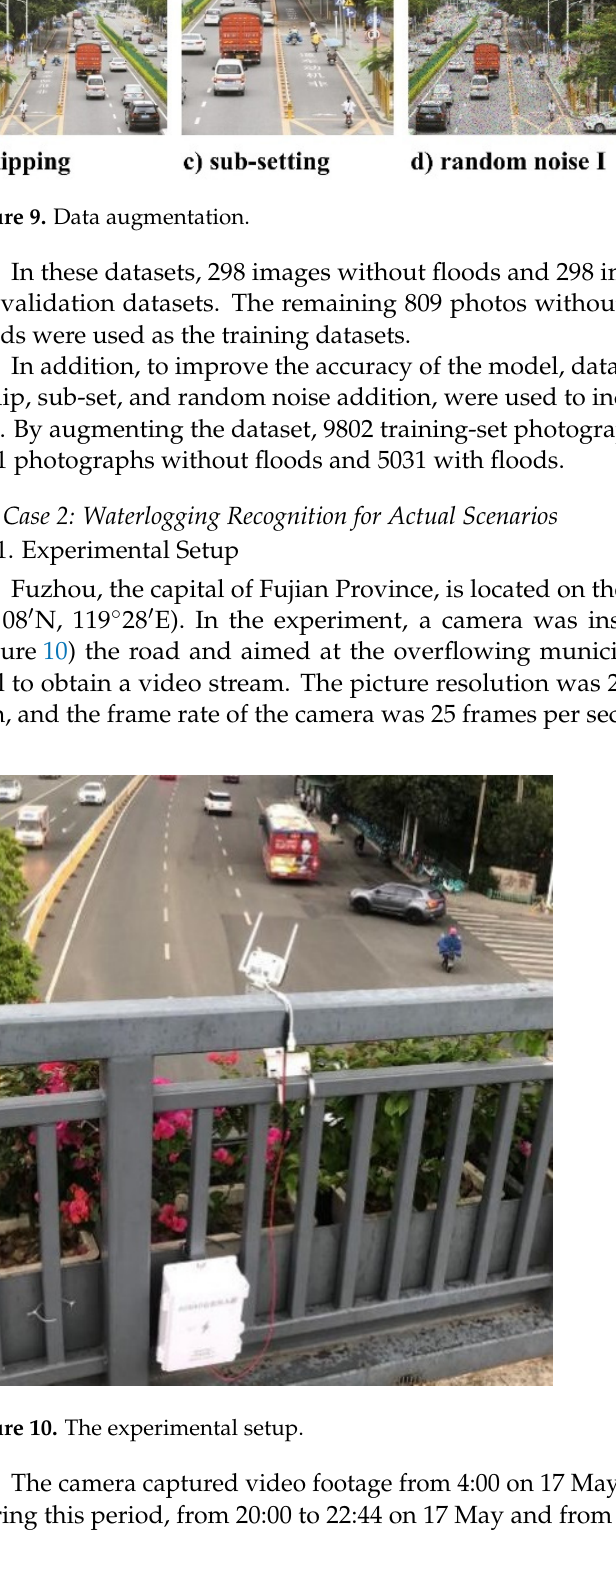
Figure 8. Images of urban streets with fl oods.